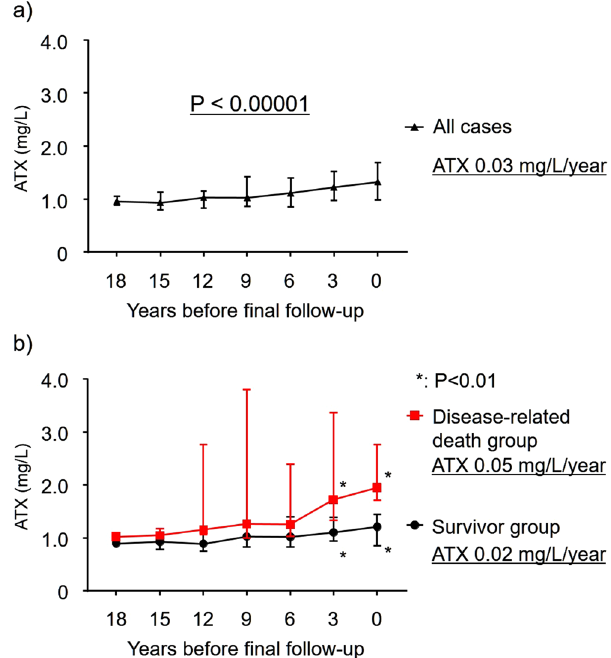
Figure 4. Clinical features of serum autotaxin (ATX) in long-term follow-up patients with primary biliary cholangitis. ATX levels were measured at the final follow-up and every 3 years beforehand in 29 patients. ATX increased significantly during follow-up in all patients (P < 0.00001). ATX levels in 21 survivors and 8